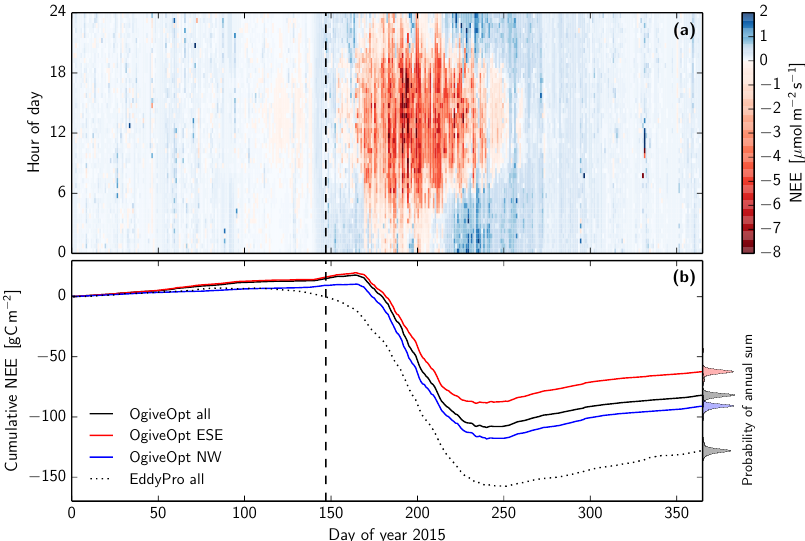
Figure 3. Gap-filled NEE fluxes for 2015. (a) Fingerprint plot of ogive optimization results. (b) Corresponding cumulative sums based on all valid measurements (black) and separately gap filled for the two footprints (colored). The probability distributions shown on the right indicate the estimated uncertainty in the annual sum due to data gaps and gap filling. The dashed line marks the time during snowmelt when daily average albedo dropped below 0.3 (27 May 2015).